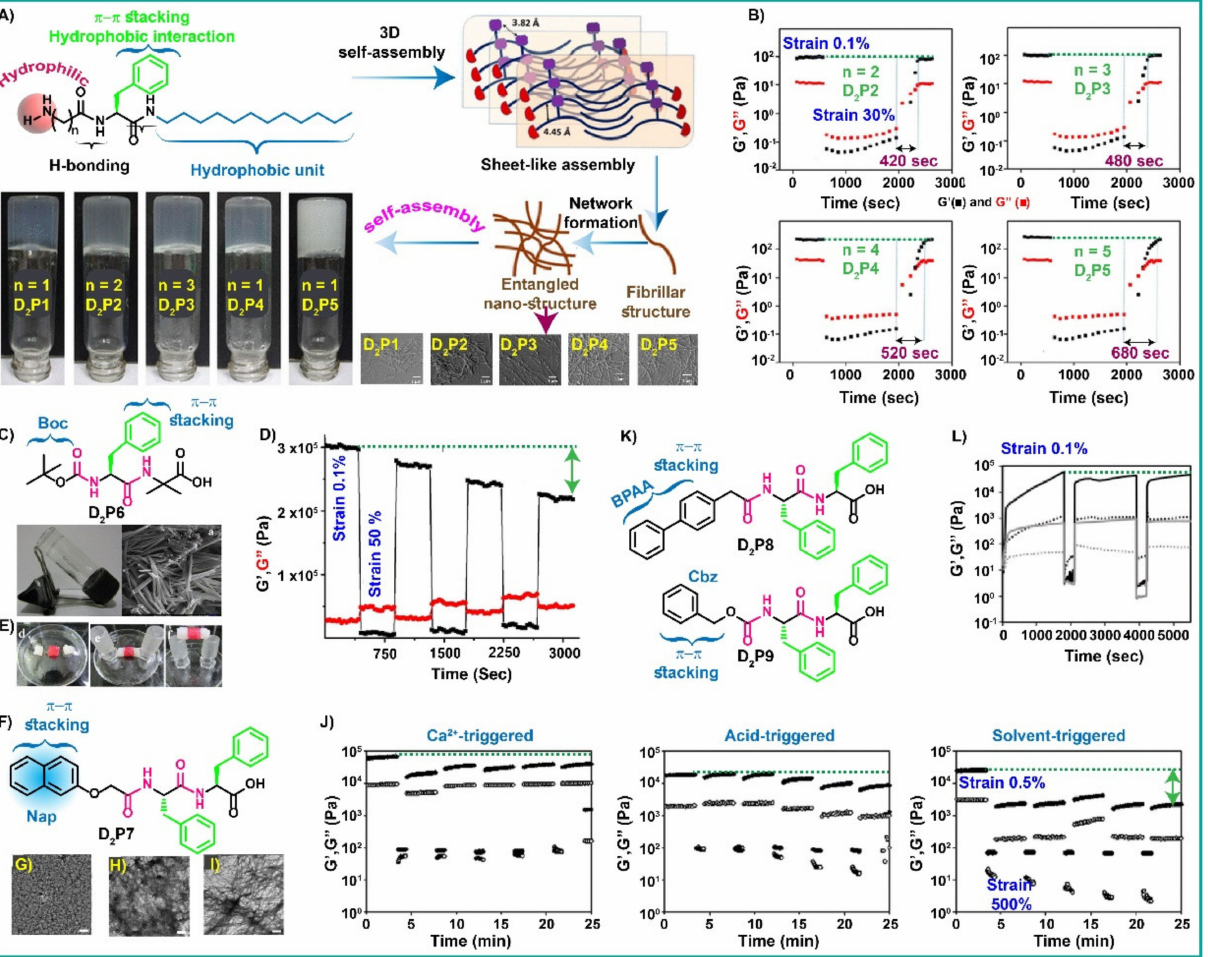
Figure 3. ( A ) Molecular structure and self-assembly of the dipeptide hydrogelators (D 2 P1-D 2 P5), FE-SEM images and vial containing hydrogel photographs. ( B ) Rheological step-strain measurements of the respective dipeptide hydrogels; reproduced with permission from Ref. [72]. Copyright (2017) American Chemical Society. ( C ) Chemical structure, gelation studies and SEM image of the dipeptide (D 2 P6) xerogel. ( D ) Thixotropy test of the D 2 P6 hydrogel. ( E ) Macroscopic self-healing ability of D 2 P6; reproduced with permission from Ref. [73]. Copyright (2018) American Chemical Society. ( F ) Molecular structure. ( G – I ) TEM image. ( J ) Recovery test of the dipeptide, D 2 P7 at different experimental conditions; reproduced with permission from Ref. [74]. Copyright (2017) Royal Society of Chemistry. ( K ) Chemical structure. ( L ) Thixotropic analysis of the dipeptide hydrogelators (D 2 P8 and D 2 P9); reproduced with permission from Ref. [75]. Copyright (2018) American Chemical